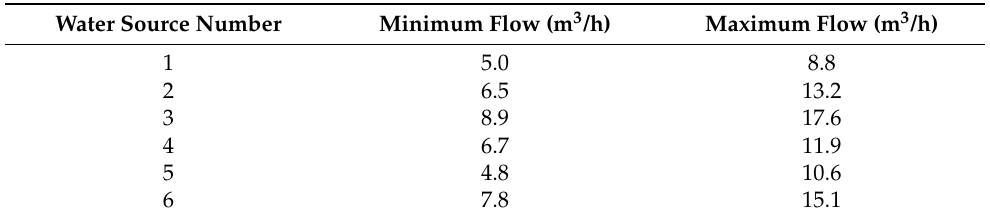
Table 4. The most recently recorded minimum and maximum possible flow that each source can deliver, at the time of